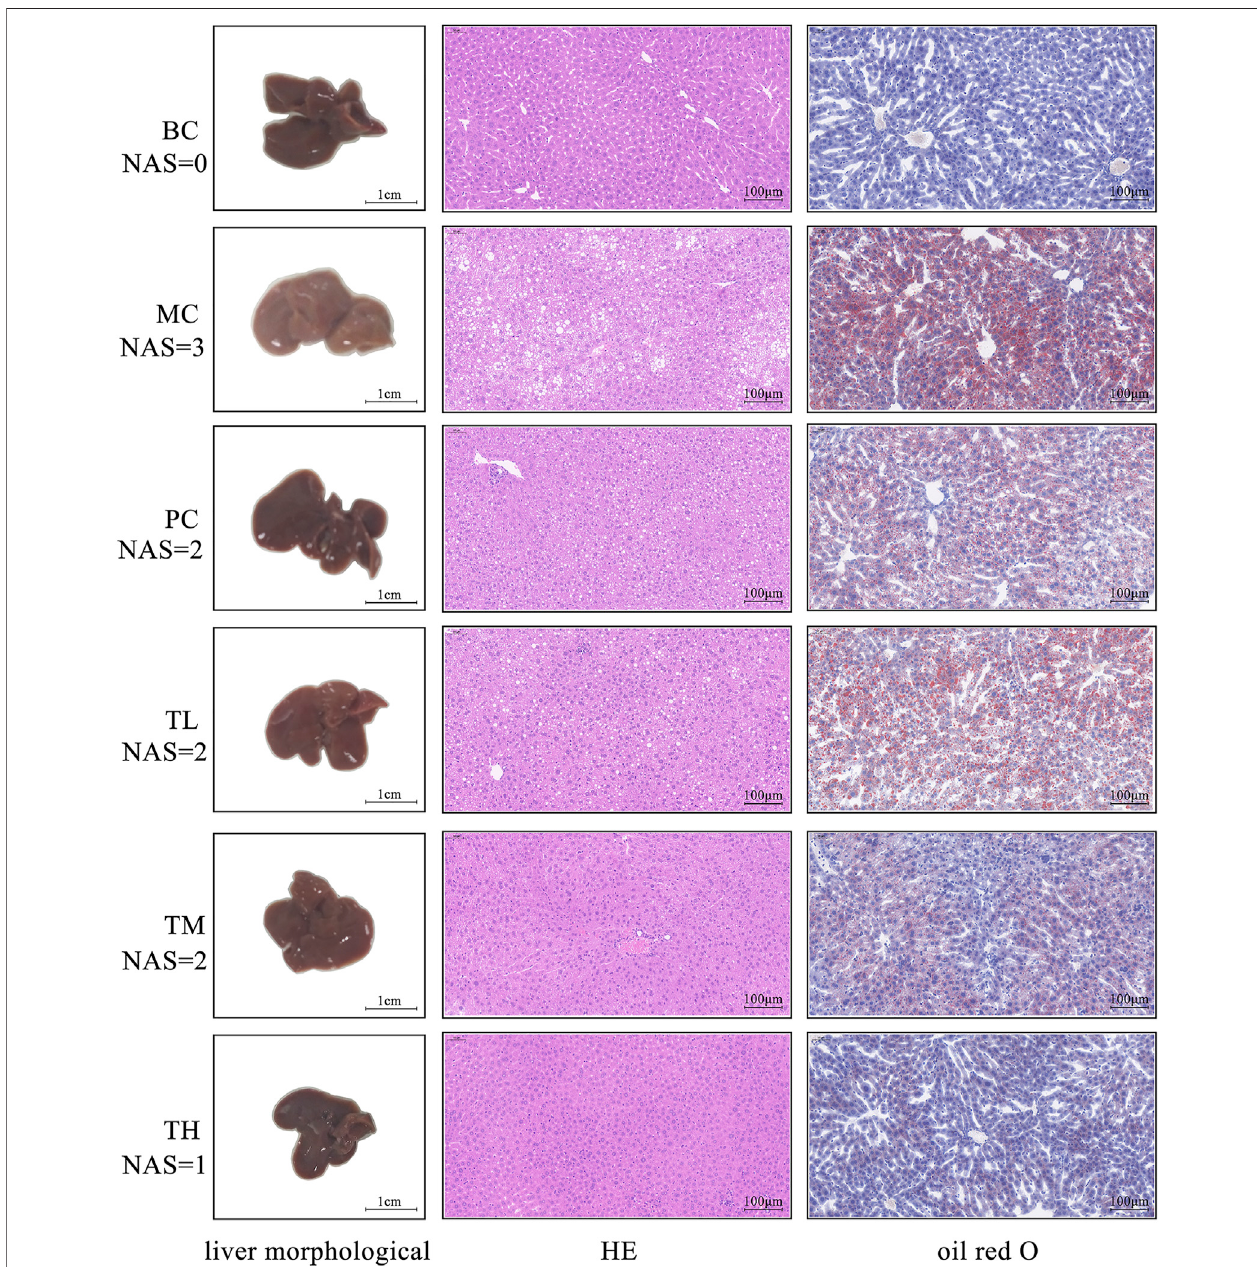
FIGURE 1 | Effects of HRG on liver morphology, liver histopathology (HE staining, ×20) and fatty lesions in mice (oil red O staining, ×20).